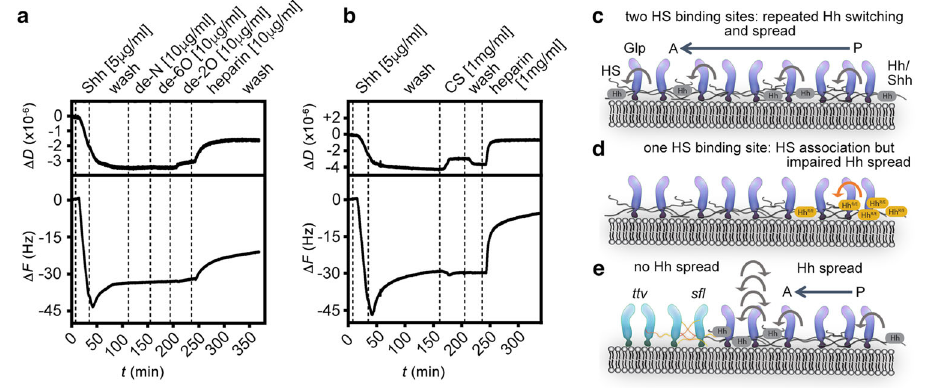
Fig.7|Shhfailstocross-linkandswitchfromheparintolowersulfatedsoluble variants. a In stark contrast to soluble heparin added to the wash buffer A, Shh doesnottransfertoselectivelydesulfatedheparinswithalessnegativenetcharge. b Shh does not switch to low-sulfated chondroitin sulfate (CS, a related type of glycosaminoglycan consisting of repeating sulfated galactosamine-glucuronic/ iduronic disaccharides instead of sulfated glucosamine-glucuronic/iduronic dis- accharides for HS), even at high CS concentrations. c Model of direct repeated Hh switching.TwobindingsitesforHSfacilitateShhdiffusioninanHSmatrixthrough competition and direct repeated switching between neighboring HS chains (bent arrows). d Functional impairment of one binding site reduces the propensity for direct competition, and thus the rate of switching between HS chains, apparently slowing Hh/Shh spread down. This is expected to result in a shorter and steeper